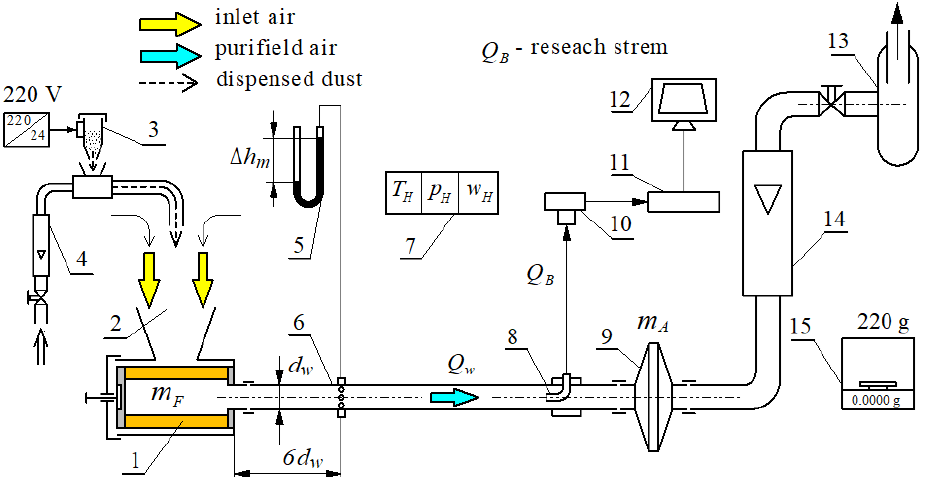
Fig. 11. Filter cartridge test stand functional diagram: 1 – filter cartridge, 2 – dust chamber, 3 – dust dispenser, 4 – rotameter, 5 – U-type manometer tube, 6 – measuring tube, 7 – humidity measurement set, ambient air temperature and pressure, 8 – measuring probe, 9 – absolute filter, 10 – sensor, 11 –